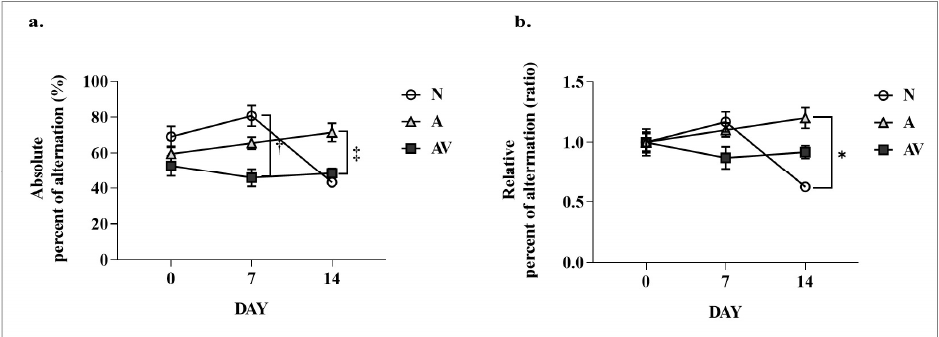
Figure 1. Results of the Y-maze test in ApoE4-KI mice after auditory and audiovisual stimulation. ( a ) absolute percentage alternation; ( b ) relative percentage alternation. † statistically significant difference between the AV and N groups at 7 days post stimulation ( p < 0.05); ‡ statistically significant difference between the AV and V groups at 14 days post stimulation ( p < 0.05); * statistically significant difference between A and N groups at 14 days post stimulation ( p < 0.05). N, no stimulation ( n = 5); A, auditory stimulation ( n = 10); AV, audiovisual stimulation ( n = 10); NS, nonsignificant.